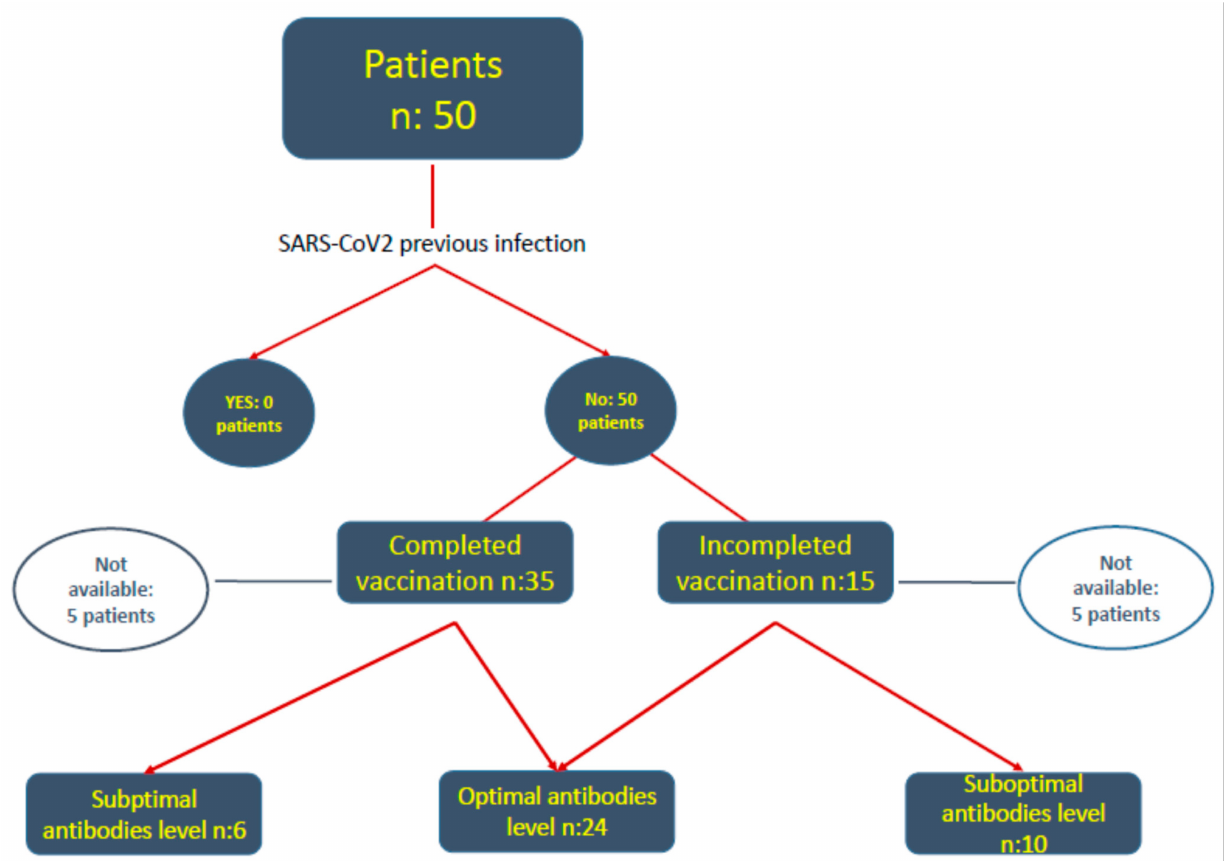
Figure 1. Shows flowchart of